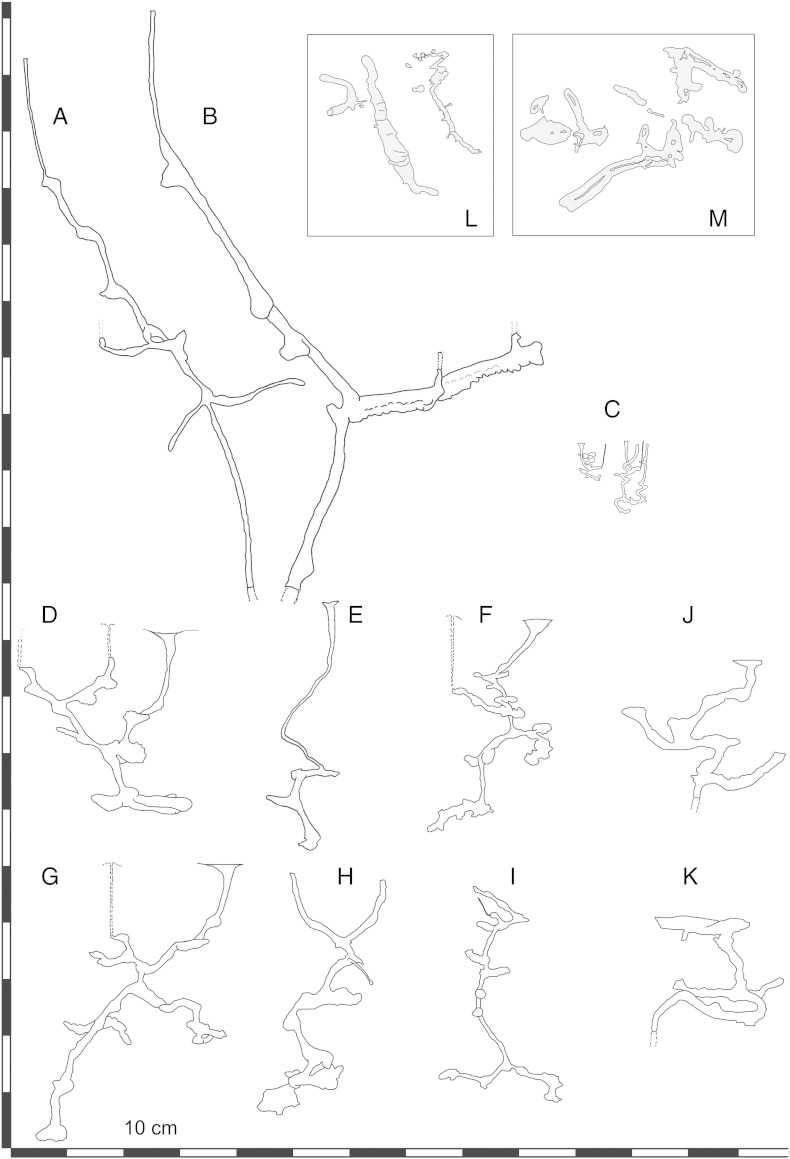
Burrow morphology of extant callianassid ghost shrimps compared to Egbellichnus jordidegiberti igen. et isp. nov. (A–B) Lepidophthalmus louisianensis, after Dworschak (2000b). (C) Paratrypaea bouvieri, after Dworschak and Pervesler (1988). (D–I) Pestarella tyrrhena; D, G, F after Dworschak et al. (2006); E after Dworschak (1987); H, I after Dworschak (2001). (J–K) Pestarella whitei, after Dworschak (2002). (L–M) Egbellichnus jordidegiberti igen. et isp. nov. as preserved in the studied section, see Fig. 3A. All burrow schemes are to scale.